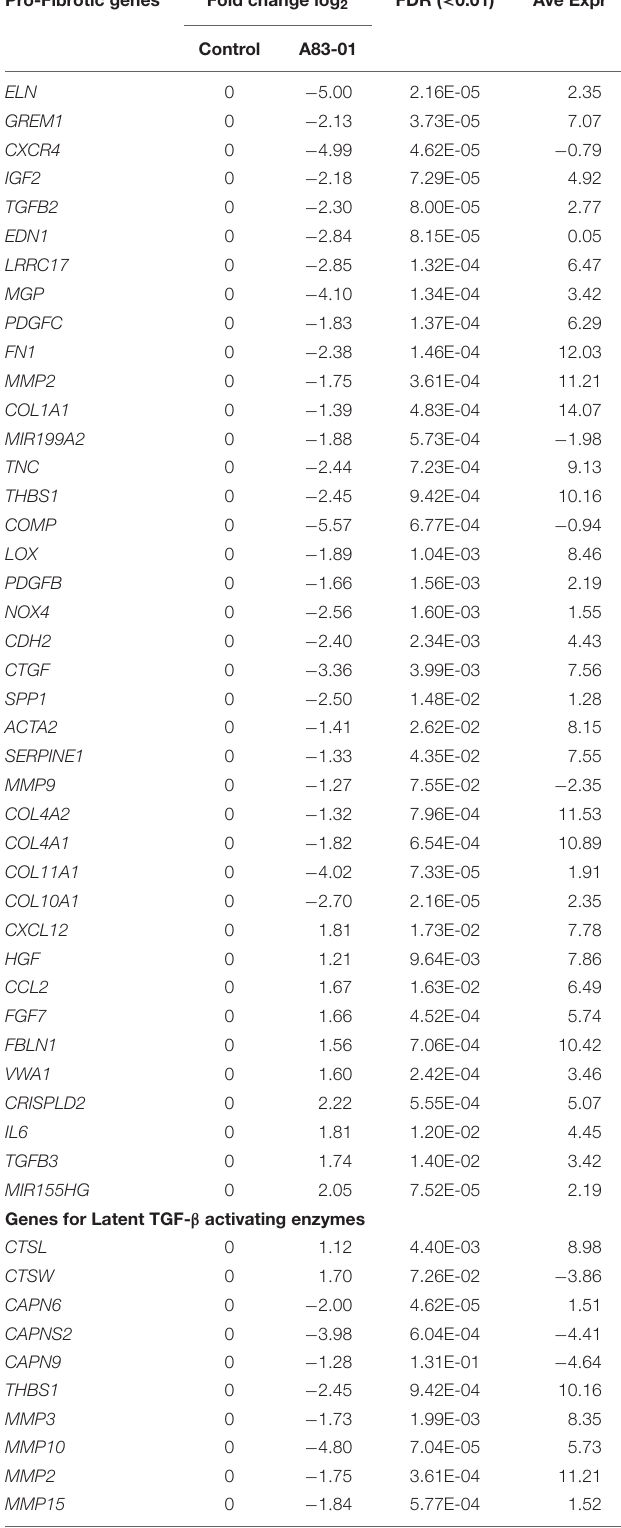
TABLE 1 | Differentially regulated fibrosis-related genes in A83-01-treated versus control eMSCs. Pro-Fibrotic genes Fold change log 2 FDR ( <